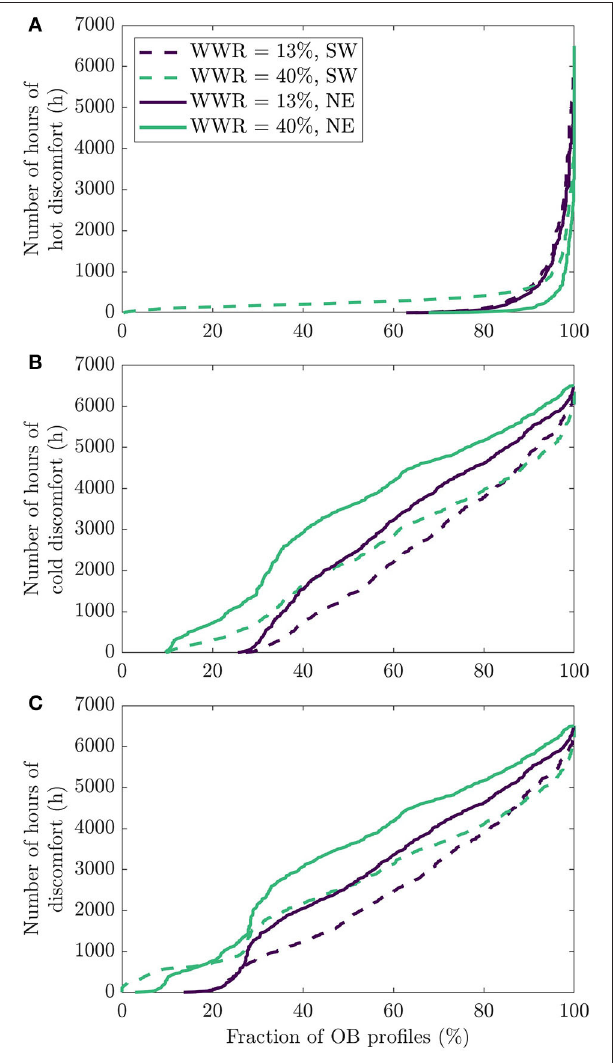
FIGURE 10 | Cumulative fraction of possible occupant behavior scenarios with a specific number of hours of discomfort for two orientations (southwest and northeast) and two window-to-wall ratios (13% and 40%) for (A) hot discomfort, (B) cold discomfort, and (C) total discomfort.